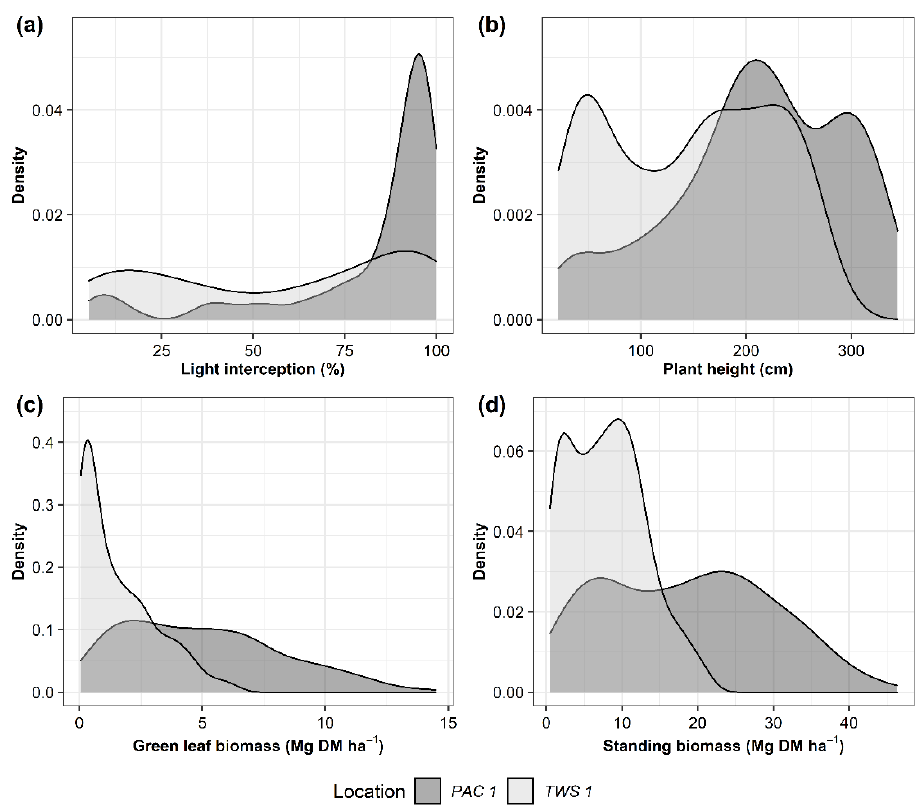
Figure 4. Frequency distribution of Miscanthus traits at the two locations in PAC 1 and TWS 1: ( a ) light interception (%), ( b ) plant height (cm), ( c ) green leaf biomass (Mg DM ha − 1 ), and ( d ) standing biomass (Mg DM ha − 1 ).